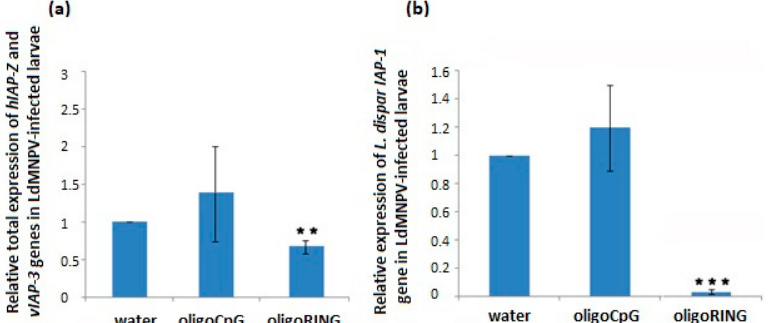
Figure 5. Expression of gypsy moth IAP-1 gene and joint expression of baculovirus IAP-3 and host IAP-Z genes after treatment with oligoDNAs. ( a ) Treatment of LdMNPV-infected larvae with oligoRING leads to significant down-regulation of total expression of hIAP-Z and vIAP-3 genes on the 6th day. Values represent means and standard errors of mRNA expression for 3 replicates relative to the water-treated control group. The significant difference between oligoRING group vs. water control is indicated by ** when p < 0.01; ( b ) Treatment of LdMNPV-infected gypsy moth larvae with the oligoRING leads to a significant decrease in expression of the host IAP-1 gene on the 14th day. Values represent means and standard errors of mRNA expression for 3 replicates relative to the water-treated control group. The significant difference between oligoRING group vs. the water-treated control group is indicated by *** when p < 0.001.